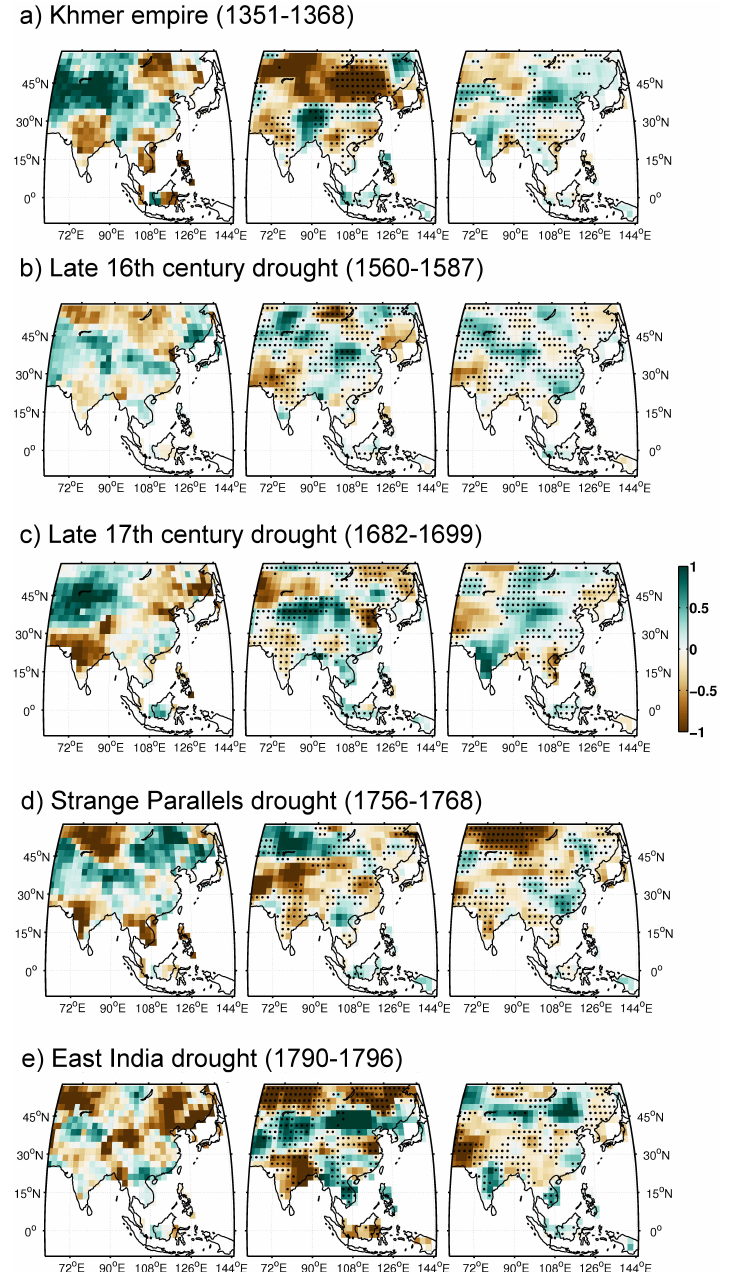
Figure 3. Drought patterns during (a) the demise of the Khmer Empire (1351–1368) (Buckley et al., 2010), (b) the late 16th century drought (1560–1587), (c) the late 17th century drought (1682–1699), (d) the “Strange Parallels” drought (1756–1768) and (e) the East India drought (1790–1796). Left panels are for MADA, middle panels for GISS-E2-R and right panels for ECHAM5/MPIOM simulations. Dots indicate that both the model and the proxy show a similar sign in PDSI